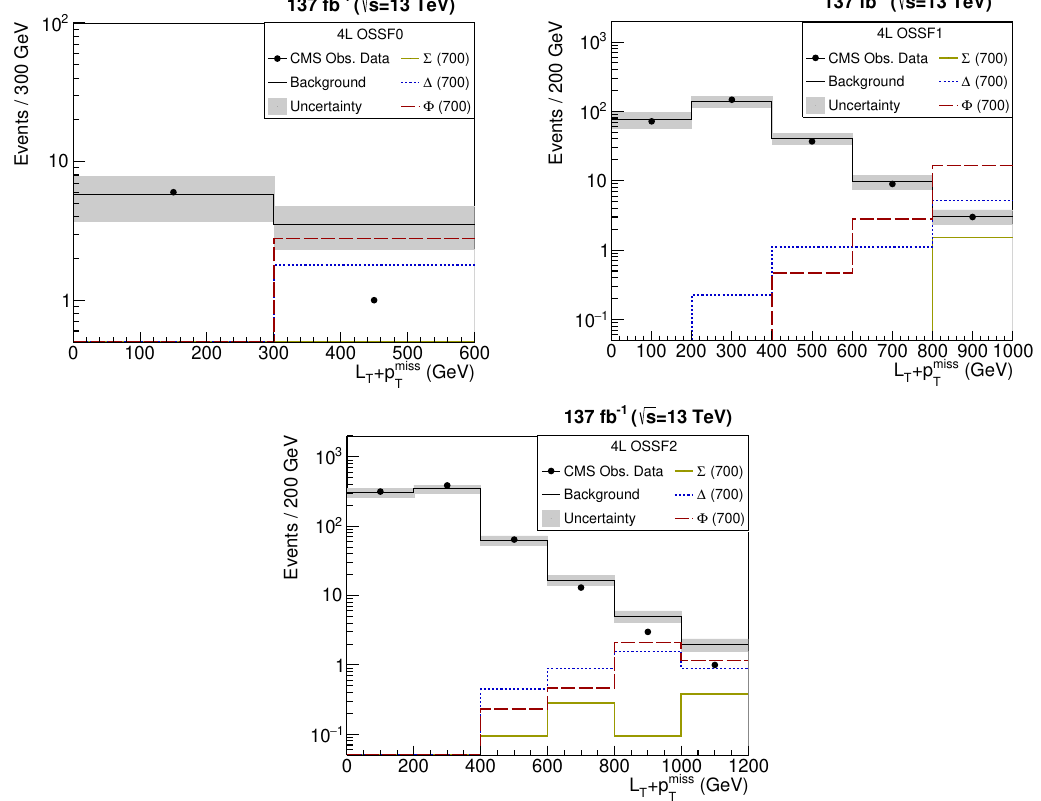
Figure 9 . Same as figure 8 for 4-lepton signal regions i.e., OSSF0 (upper left), OSSF1 (upper right) and OSSF2 (lower). See text for